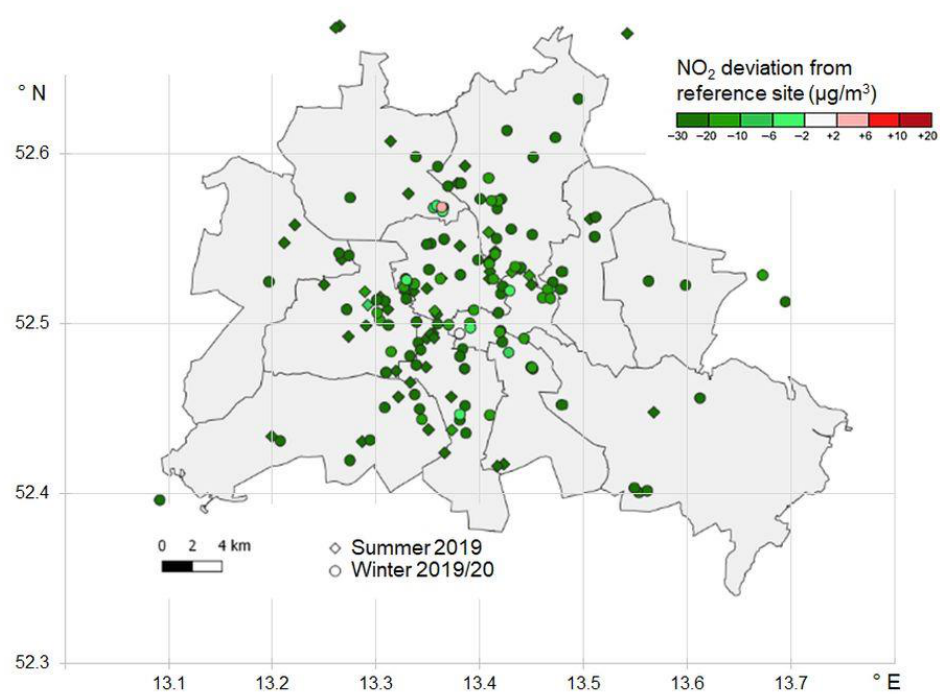
Figure 3. Deviation of NO 2 concentrations at sampling sites from summer 2019 and winter 2019/2020 with respect to the BLUME monitoring network traffic measurement station “Karl-Marx-Straße”. Secondly, the representativeness of the citizen science and BLUME data was analyzed.